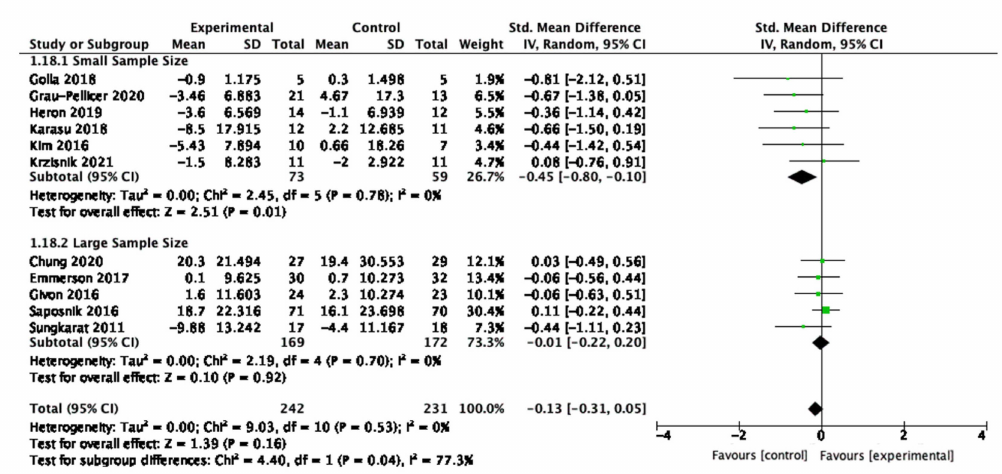
Figure 16. Sensitivity analysis for sedentary